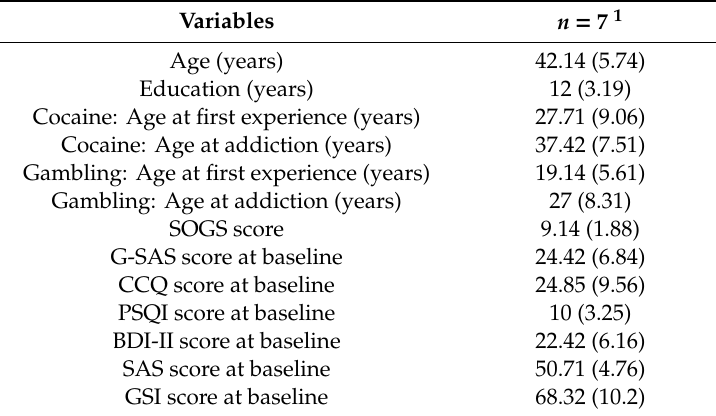
Table 1. Demographic and clinical characteristics of the